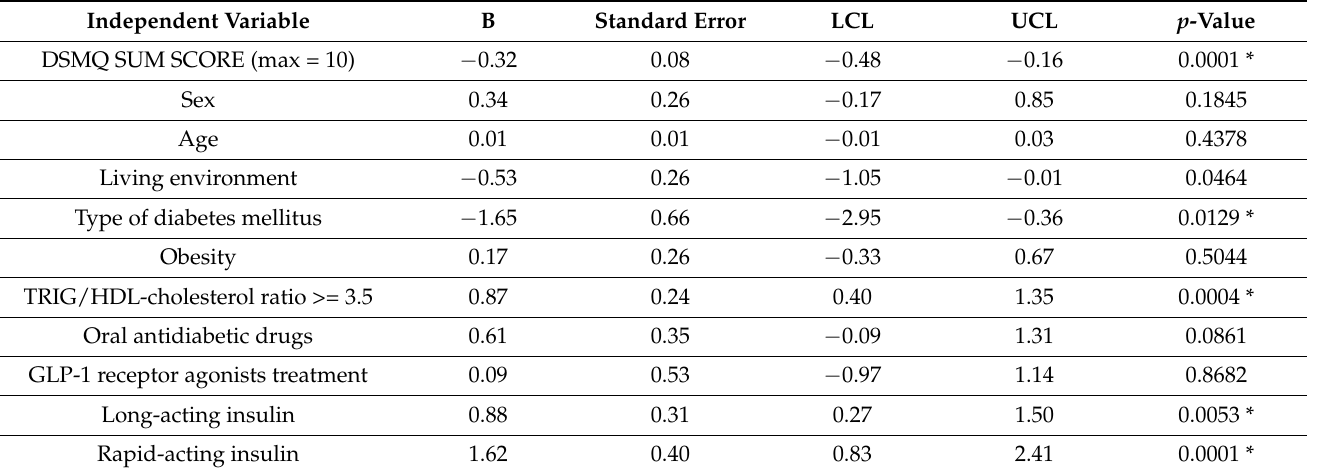
Table 3. Multivariate linear regression model with HbA1c as the dependent variable, and multiple independent variables.